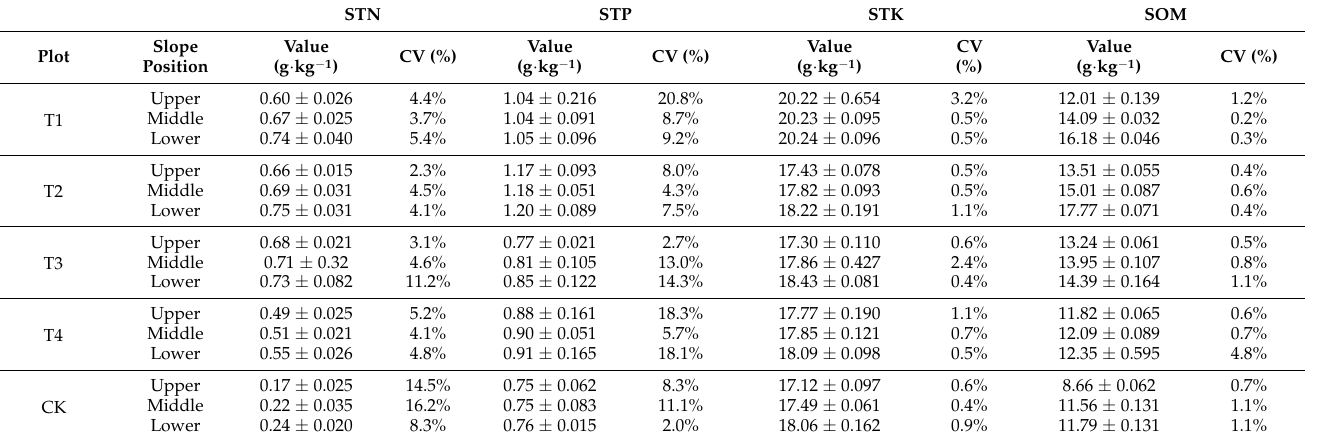
Table 1. Descriptive statistics of the STN, STP, STK, and SOM contents under different hedgerow